Question: Is the quantity shown trending increasing or decreasing?
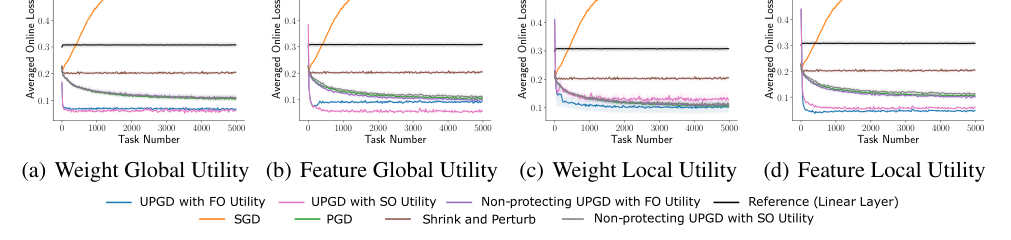
Answer: increasing